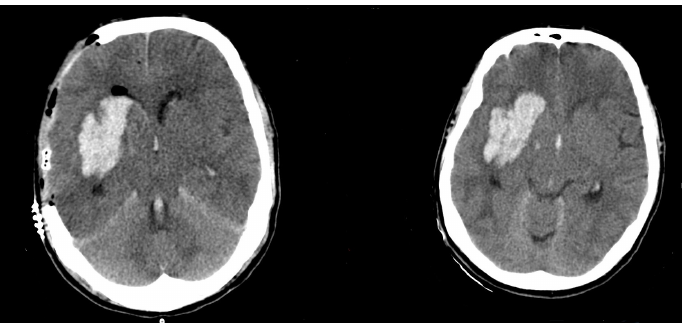
Figure 2. Postoperative ( left )/Preoperative ( right ) CT scan of a patient without hematoma